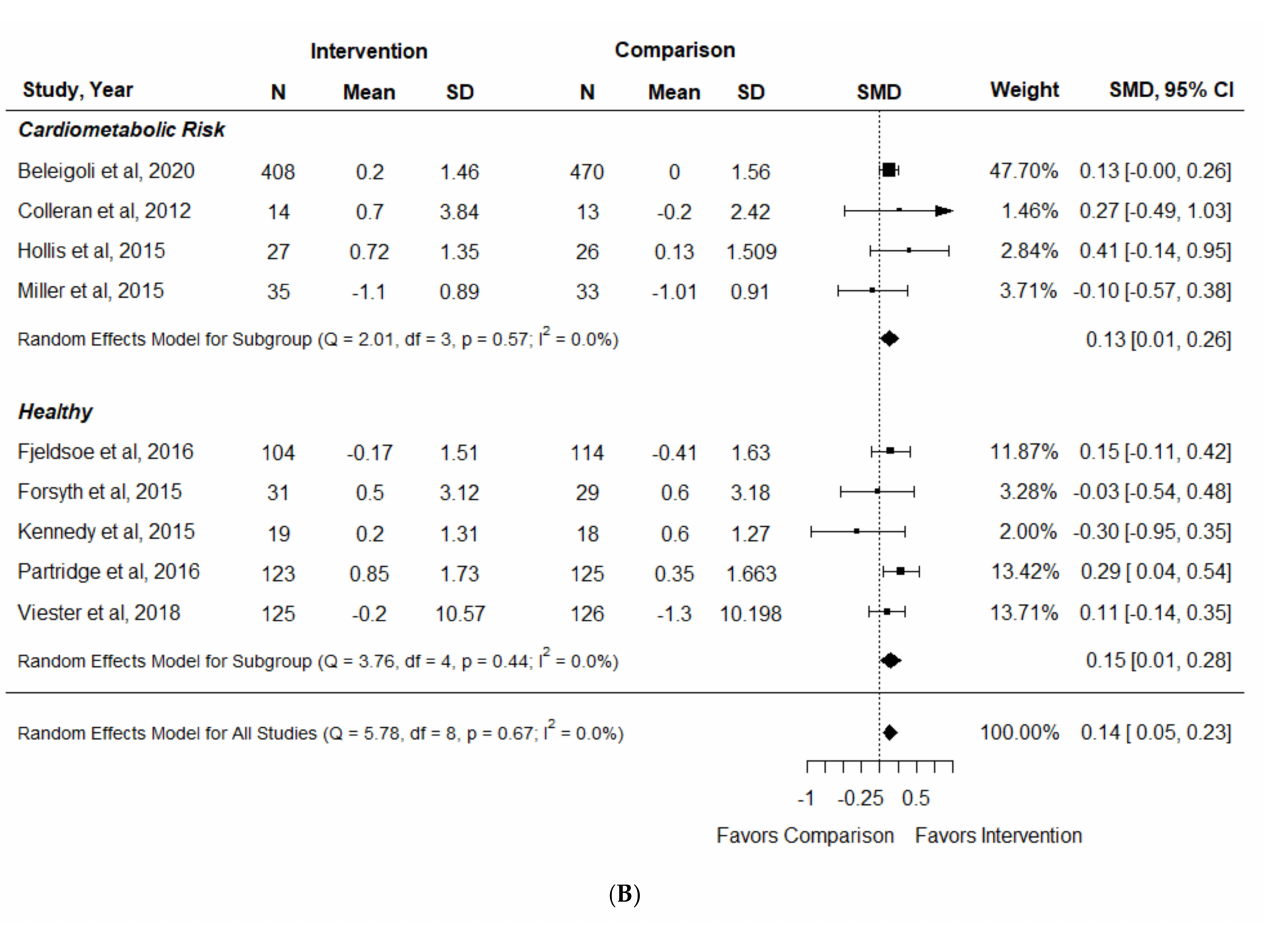
Figure 4. Forest plot for ( A ) fruit and ( B ) vegetable intake in the systematic review examining effect of nutrition and physical activity interventions provided by nutrition and exercise practitioners for the general population